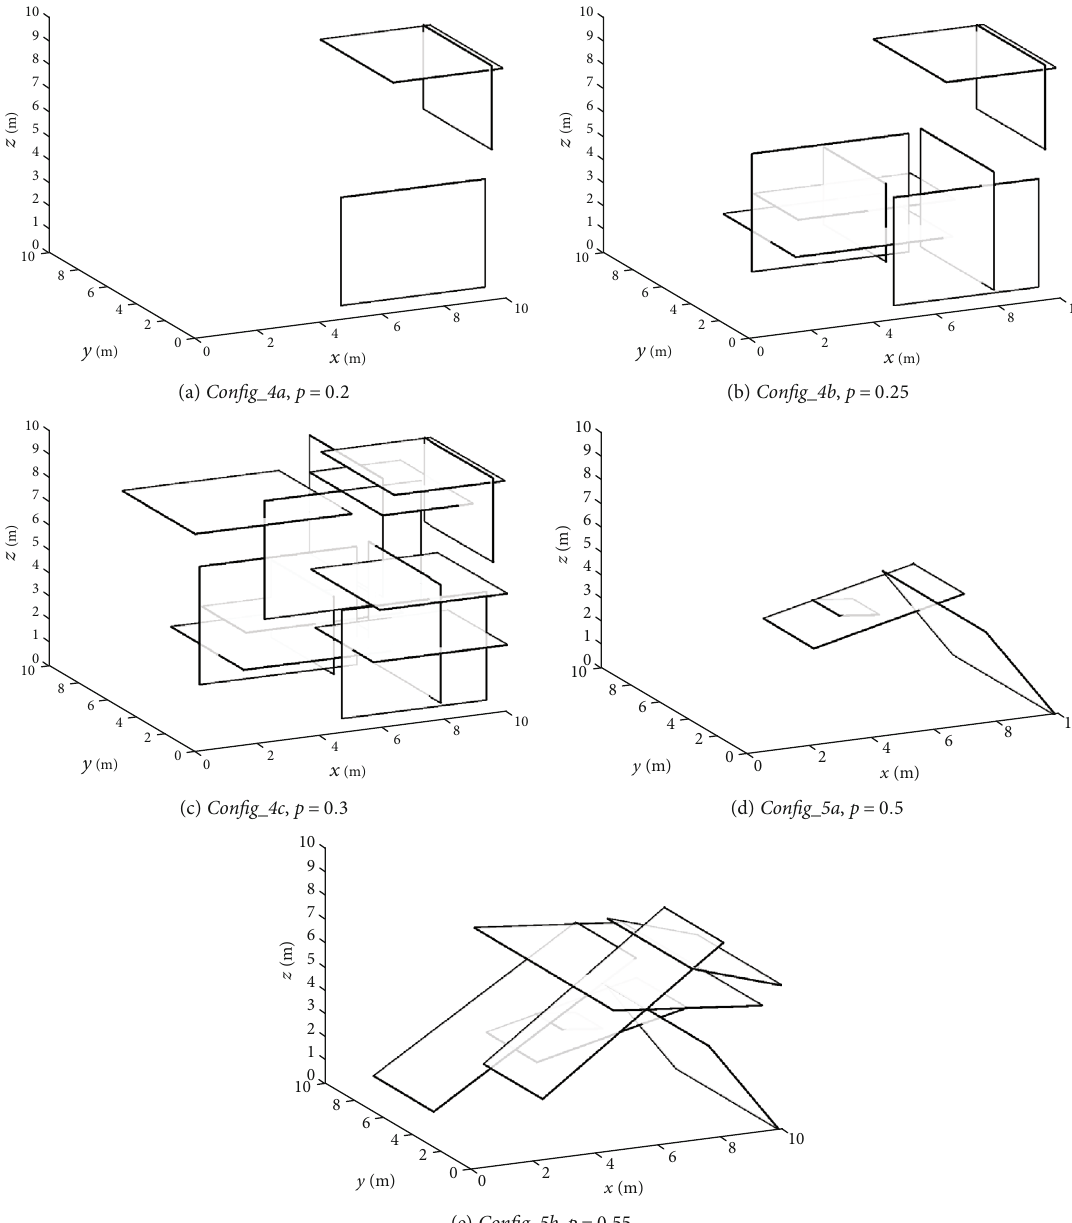
Figure 7: Random fracture networks considering (a – c) orthogonal families of fractures and (d, e) random orientations for various values of the percolation parameter p